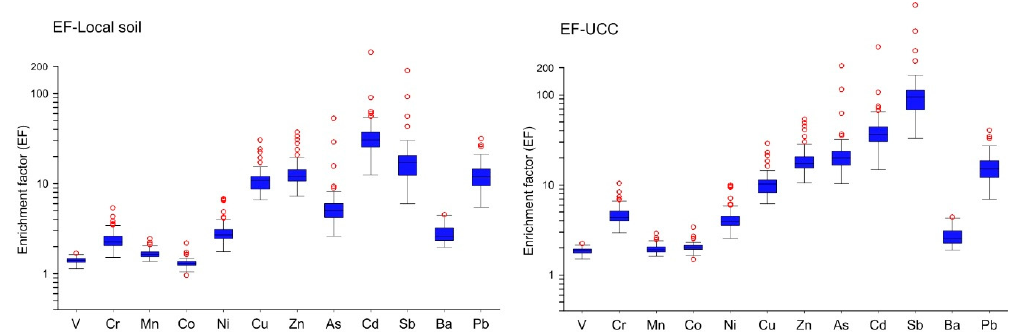
Figure 2. EF values of potentially toxic elements in settled dust in the Beijing urban area relative to the local natural soil and the UCC, respectively.